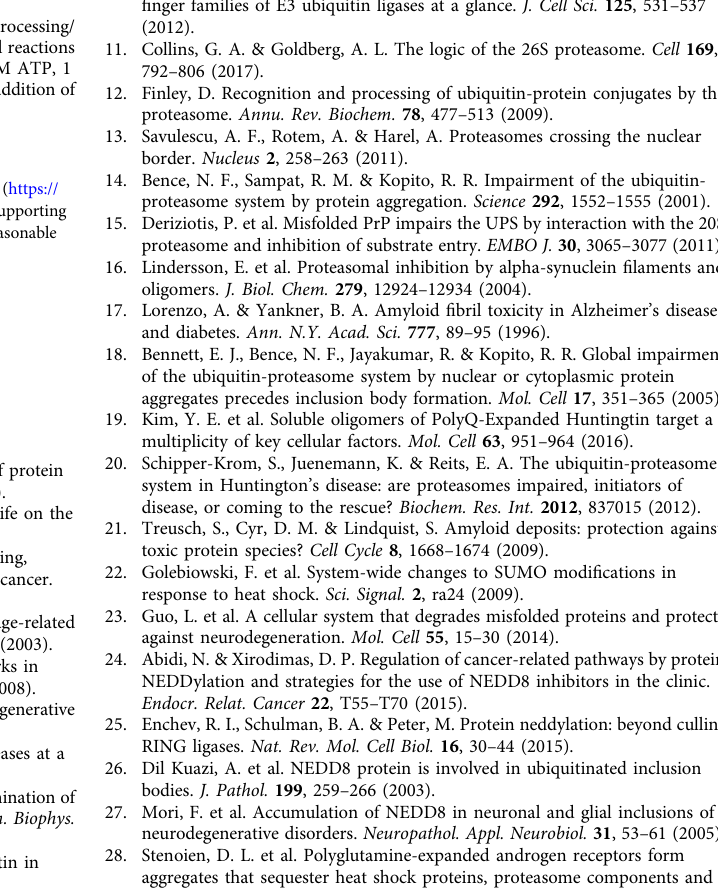
protease at 30°C, 1h. After measuring protein concentration proteasomes were kept at − 80 °C. One microgram of puri fi ed 26S proteasomes was used in an in vitro processing/ degradation assay with 300 ng of puri fi ed His 6 -tagged conjugates in 40 μ l reactions containing 25mM Tris-HCl, pH 7.5, 10 mM MgCl 2 , 10% glycerol, 1mM ATP, 1 mM DTT at 37°C as described in ref. 66 . Reactions were stopped by the addition of